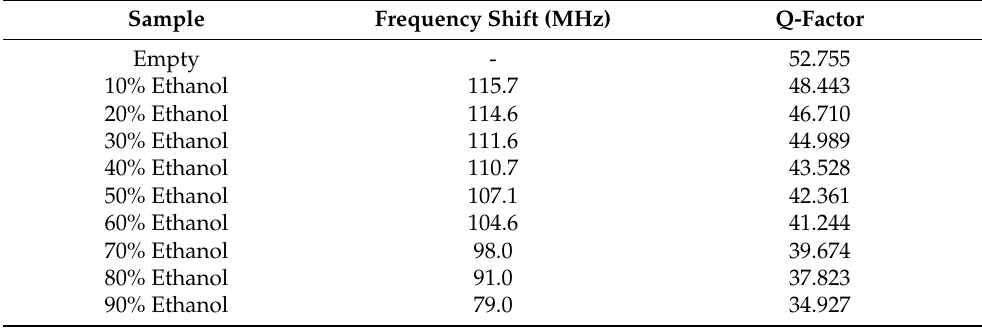
Figure 12. Measured transmission response of different concentrations of IPA solution. Table 5. The resonant frequency and Q-factor of different concentrations of ethanol-water